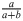
Heatmap of deviation from 1:1 segregation of homozygotes at various population sizes and selection strengths.Lower selection strengths are highly dependent on population size. As population size decreases, the influence of sampling error on segregation ratios increases, leading to high segregation distortion even in the case of weak selection. Each tile is an average value over 20 simulations with 20 markers at evenly spaced intervals, totalling 100 centimorgan. Deviation is calculated as ∑(y − 0.5)2 where y is the ratio of homozygous genotypes aa+b at an arbitrary locus; a is the number of homozygous genotypes from parent 1, b is the number of homozygous genotypes from parent 2 at an arbitrary locus.